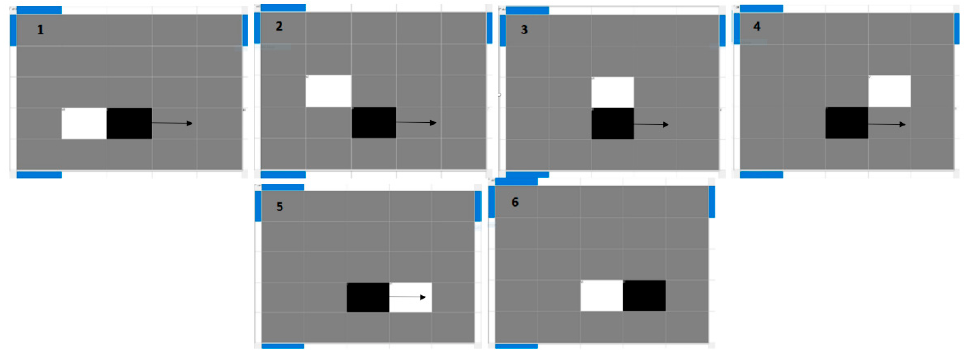
Figure 5. An example of a 3 ‐ move scenario.